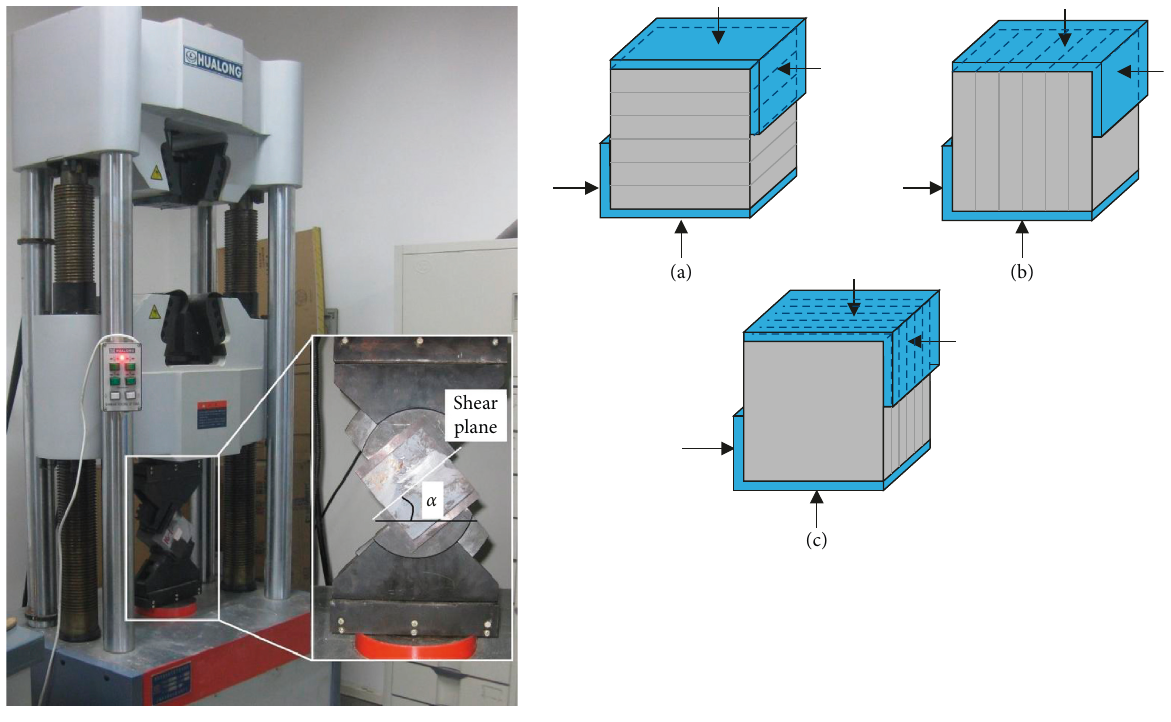
Figure 4: Loading modes for shear